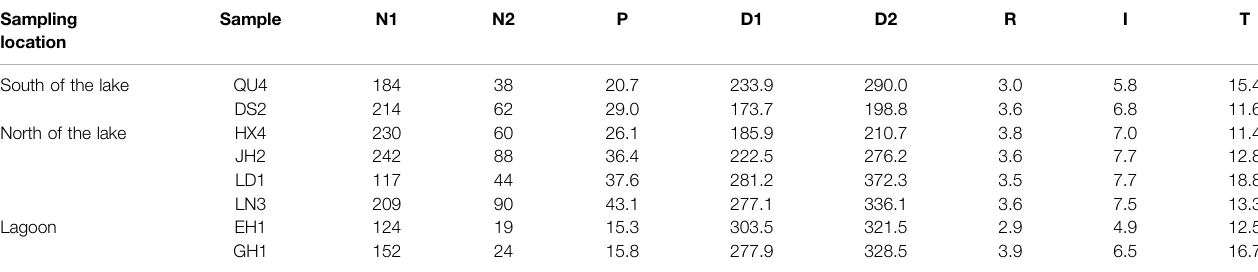
TABLE 2 | Data table for the samples from the lake and lagoon. Sampling